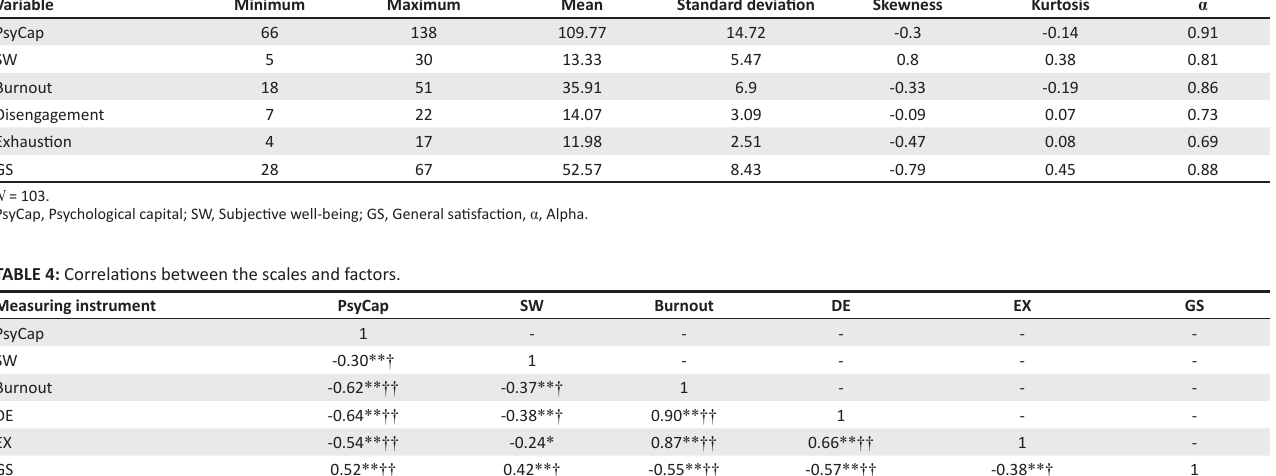
TABLE 3: Descriptive statistics and reliability statistics for the scales. Variable